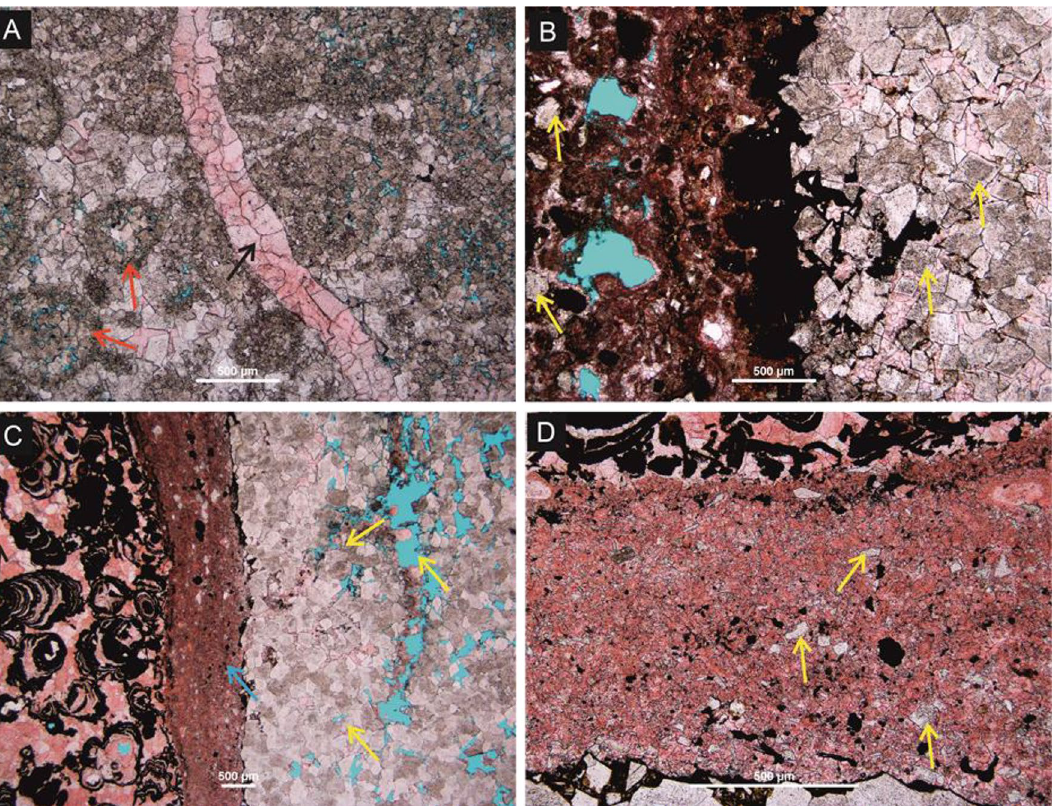
Figure 4. Petrographic images of different microscopic textures and fabrics observed in the Lower Jurassic carbonate, EAB. ( A ) Fracture cross cuts ooid packstone-grainstone facies, filled by blocky calcite cement (black arrow). Note the ooids were pervasively replaced by dolomite (red arrow) ( B ) Termination of dolomite fronts to mud-dominated limestone. Note the presence of isolated dolomite rhombs in the host limestone (yellow arrow). ( C ) Fracture-bounded dolomite fronts (yellow arrows) with sharp termination. The fracture is filled by fine-grained sediments (blue arrow). Blocky calcite cement indicated by a black arrow. ( D ) A close-up view